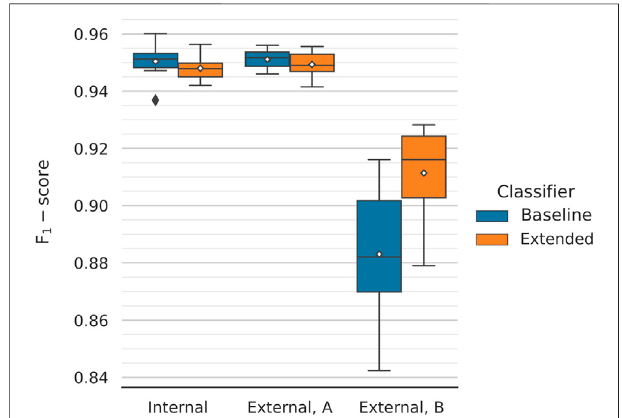
FIGURE 4 | Classi fi cation performance comparison between the two models for different validation datasets. The performance across 10 folds is being reported. Mean values are annotated with white diamonds. Both classi fi ersperformvirtuallyidenticallyduringinternalvalidation(macroF 1 - scores of 95.04 ± 0.61% and 94.80 ± 0.41%, respectively) and equally well when tested on the fi rst external dataset (micro F 1 -scores of 95.11 ± 0.34% and 94.93 ± 0.48%, respectively). The models are not over fi tting. There is a signi fi cant drop in performance when testing on the second external dataset (meant to assess the classi fi er ’ s generalisability). However, the extended model performsconsiderably better, witha(micro)F 1 -score of91.14±1.62% compared to the baseline ’ s 88.30 ±